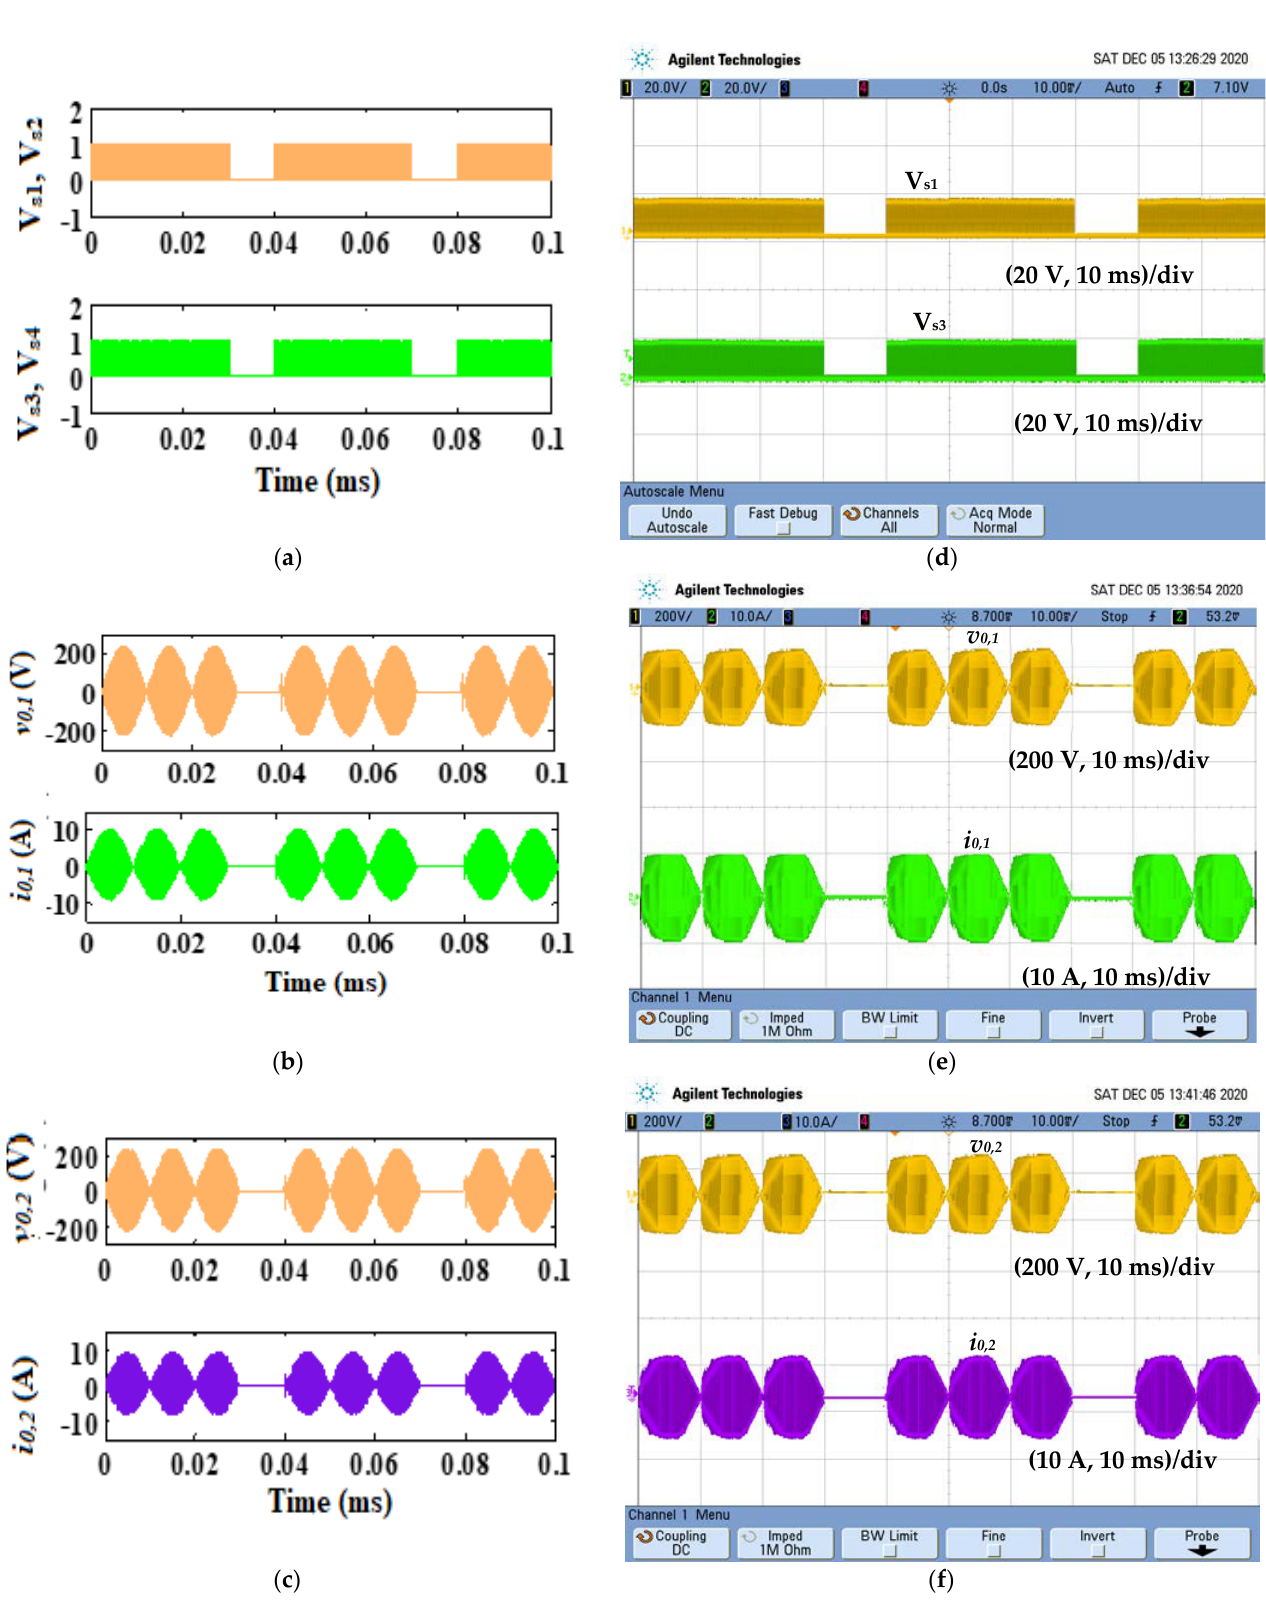
Figure 9. Main waveforms for 75% D PDM : simulation waveforms ( a ) switching pulses, ( b ) output voltage and current of load 1, ( c ) output voltage and current of load 2, experimental waveforms ( d ) switching pulses, ( e ) output voltage and current of load 1, ( f ) output voltage and current of load 2.